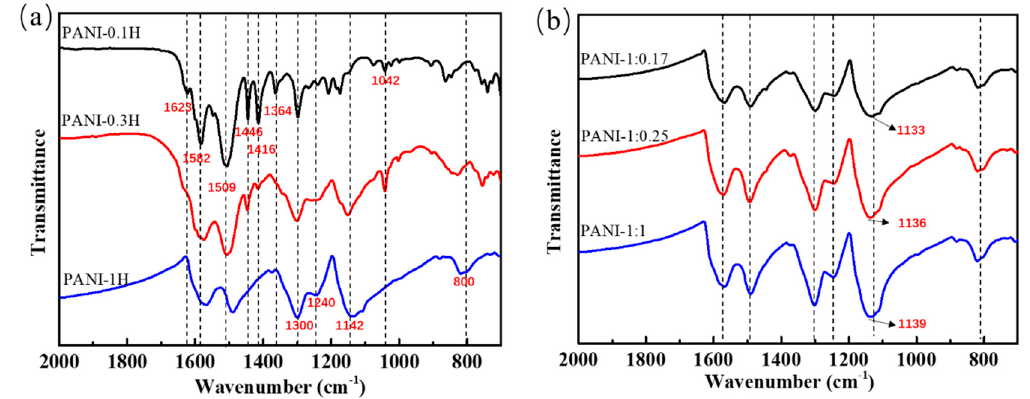
Figure 1. FTIR spectra of PANIs synthesized at different reaction conditions. ( a ) Different HCl concentrations; and ( b ) Different APS concentrations.